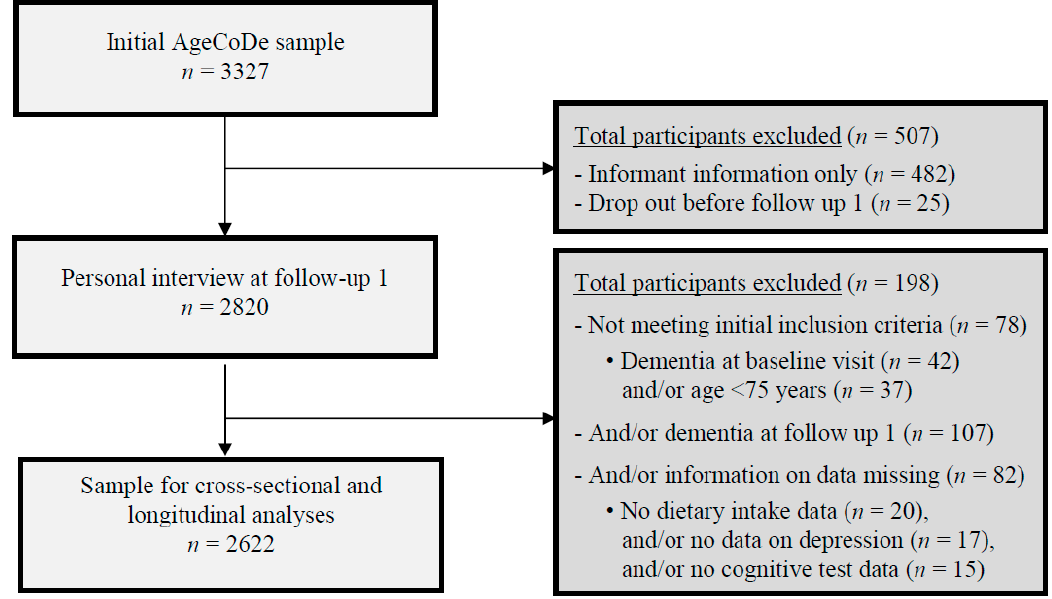
Figure 1. Flow chart of the participants included in the AgeCoDe study. Abbreviations: AgeCoDe, German Study on Aging, Cognition and Dementia in Primary Care Patients.